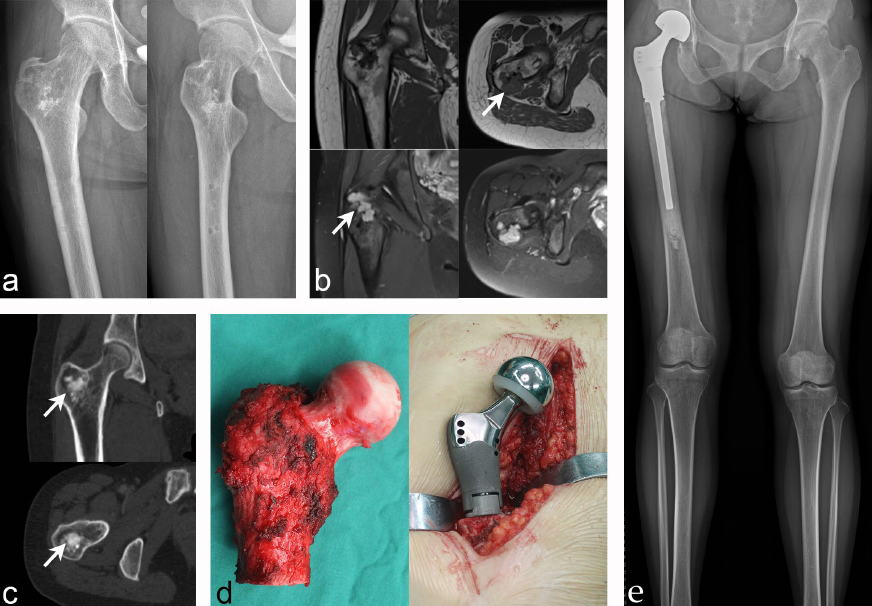
Figure 1. Case 4: PMT of the proximal femur that underwent radical resection and tu-mor-type artificial joint replacement. ( a ) Anteroposterior and lateral X-rays of the proximal femur revealed intertrochanteric bone abnormalities. ( b ) MRI showed low intensity on T1WI and high intensity on T2WI (white arrow indicates the lesion). ( c ) CT showed heterogeneous lesion density with osteogenic changes (white arrow indicates the lesion). ( d ) Tumor segment resection and tumor-type artificial hip replacement were performed. ( e ) Postoperative X-ray showed that the prosthesis was stable and the lower limbs were basically equal in length.